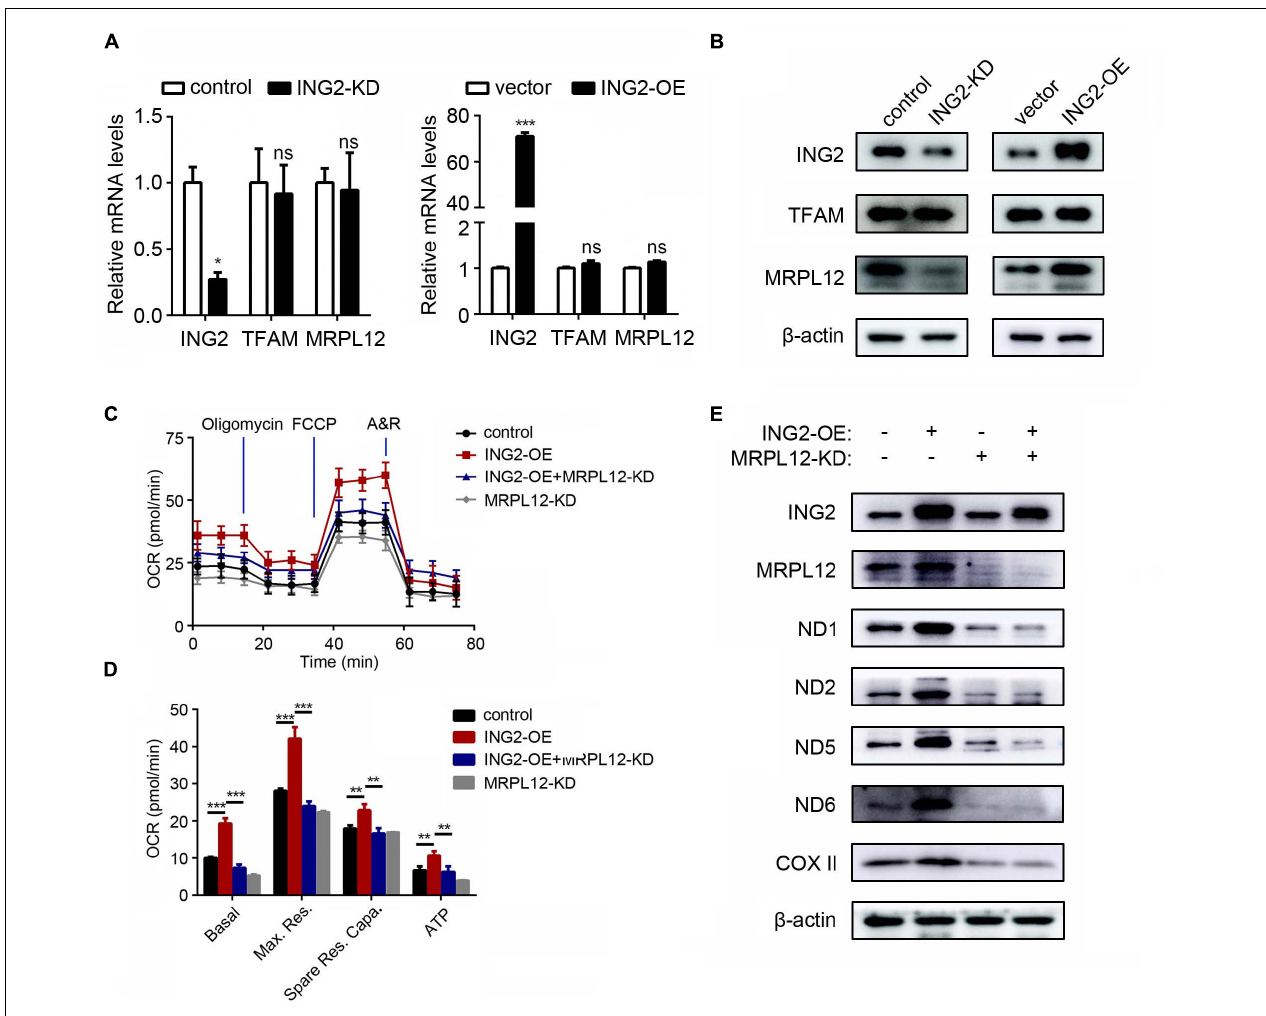
FIGURE 2 | MRPL12 mediated the effects of ING2 on mitochondrial OXPHOS in tubular epithelial cells. (A,B) HK2 cells were transfected with ING2-shRNA or ING2-overexpression plasmid. The mRNA and protein levels of TFAM and MRPL12 were evaluated by qPCR and Western blotting. (C,D) HK2 cells were divided into control group, ING2 overexpression group, MRPL12 knockout group, and MRPL12 knockout plus ING2 overexpression group. Mitochondrial OXPHOS was detected using Seahorse. OCR, oxygen consumption rate; FCCP, carbonyl cyanide 4-(trifluoromethoxy)phenylhydrazone; A&R, antimycin and rotenone. (E) Western blotting to validate the altered expression of mtDNA-encoded components of mitochondria complex. Data were from three individual experiments and presented as mean ± SEM. * p < 0.05, ** p < 0.01, *** p < 0.001. ns, not